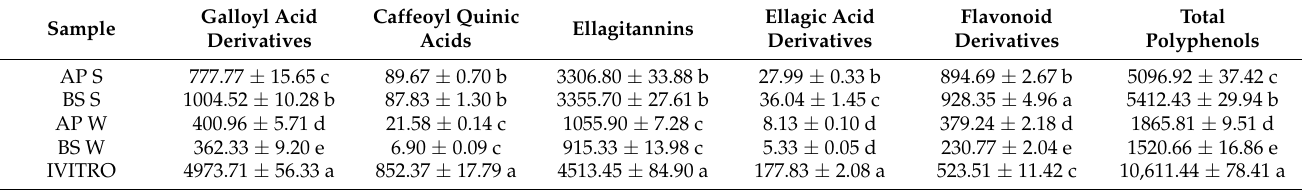
Median ± E.E. (one-way ANOVA, Tukey, p ≤ 0.05, n = 3). Different letters in the same row indicate significant differences according to Tukey’s test. BS W: Basal winter leaves, AP W: apical winter leaves, BS S: basal spring leaves, AP S: apical spring leaves, and IVITRO: in vitro